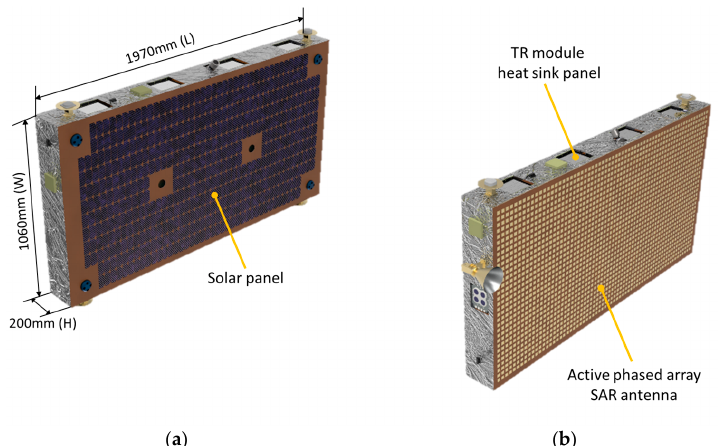
Table 1. S-STEP s atellite s ystem s pecifications [25–27].